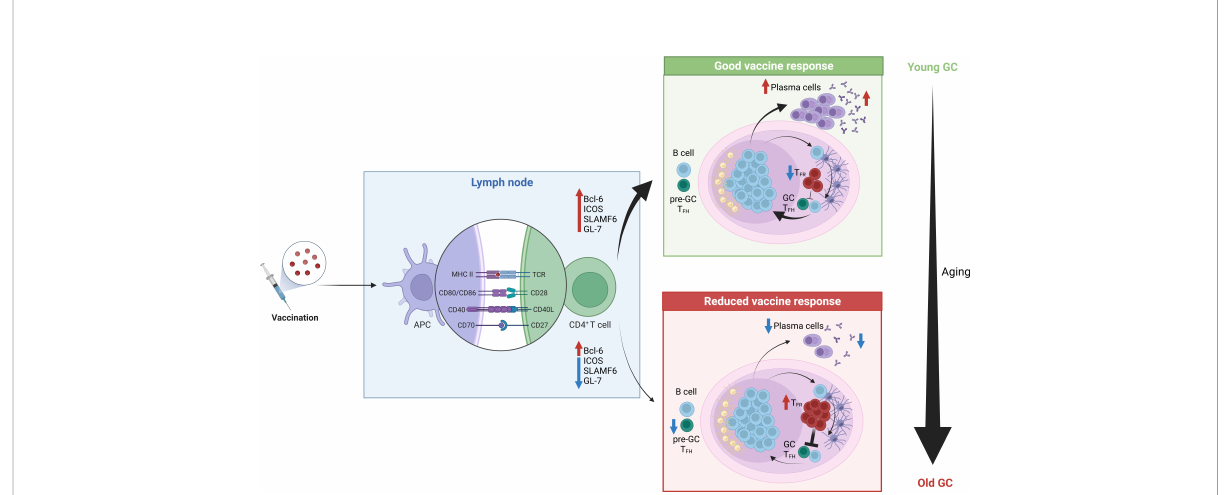
FIGURE 2 Reduced vaccine response in the elderly. Upon antigenic stimulation, antigen presenting cells capture, process and present the antigen to naïve CD4 + T cells in the draining lymph node. Upon the formation of an immunological synapse between these two cell types, in young individuals naïve CD4 + T cells get ef fi ciently activated and acquire a T FH -like phenotype by up-regulating Bcl-6, ICOS, SLAMFF6 and GL-7. Consequently, they migrate to the GC, where they will sustain a T cell-depedent B-cell response. Finally, mature plasma cells will be generated, and they